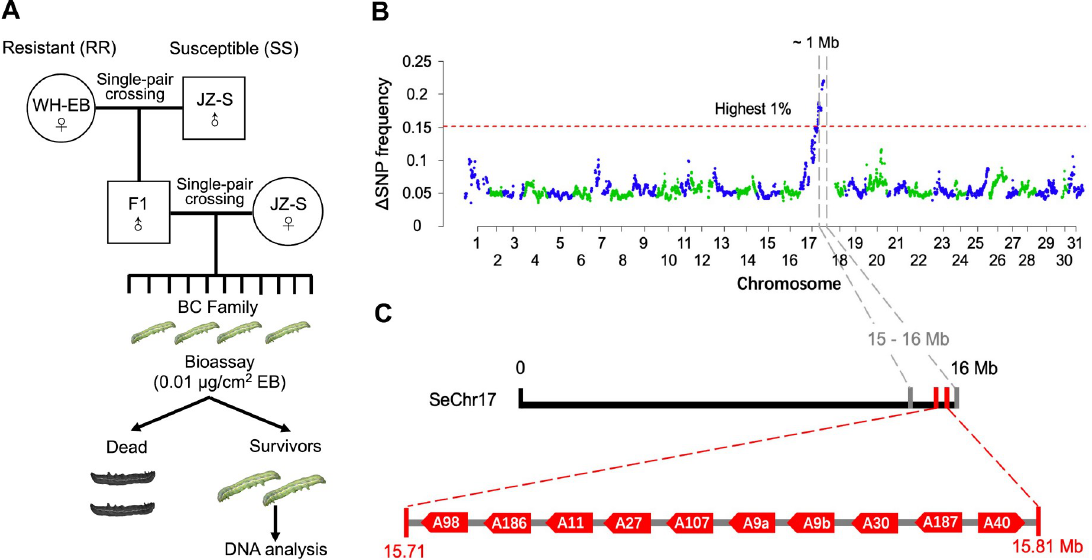
Fig 2. Experimental design for crosses, bioassays and bulked segregant analysis (BSA) to map emamectin benzoate resistance. ( A ) Single-pair crosses between JZ-S and WH-EB virgin adults produced families of hybrid F 1 offspring. A male F 1 was backcrossed to a female JZ-S to produce the backcross (BC) family. Progeny from the BC family were exposed to a diagnostic concentration of EB of which 120 survivors and their F 1 parents were analyzed by next-generation sequencing (NGS). ( B ) BSA mapping revealed a 1 Mb genomic region in chromosome 17 highly correlated with EB resistance in WH-EB. The mean frequency deviation values obtained from a sliding window analysis (1 Mb window with 100 Kb step) were plotted across all 31 chromosomes of the genome. The red dashed line corresponds to the top 1% threshold of the SNP-index likely containing changes linked with EB resistance. ( C ) Expanded map of chromosome 17 (from 15 Mb to 16 Mb) that includes the CYP9A gene cluster (15.71 Mb to